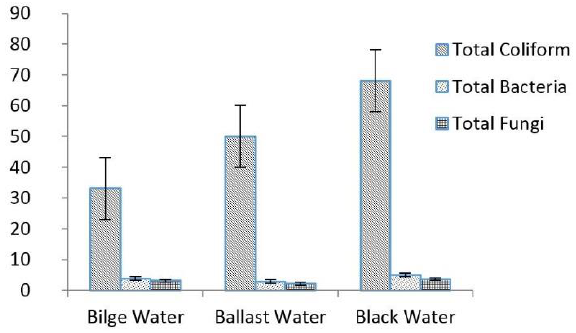
Figure 5. Distribution of the trace metal parameters of shipborne wastewater.